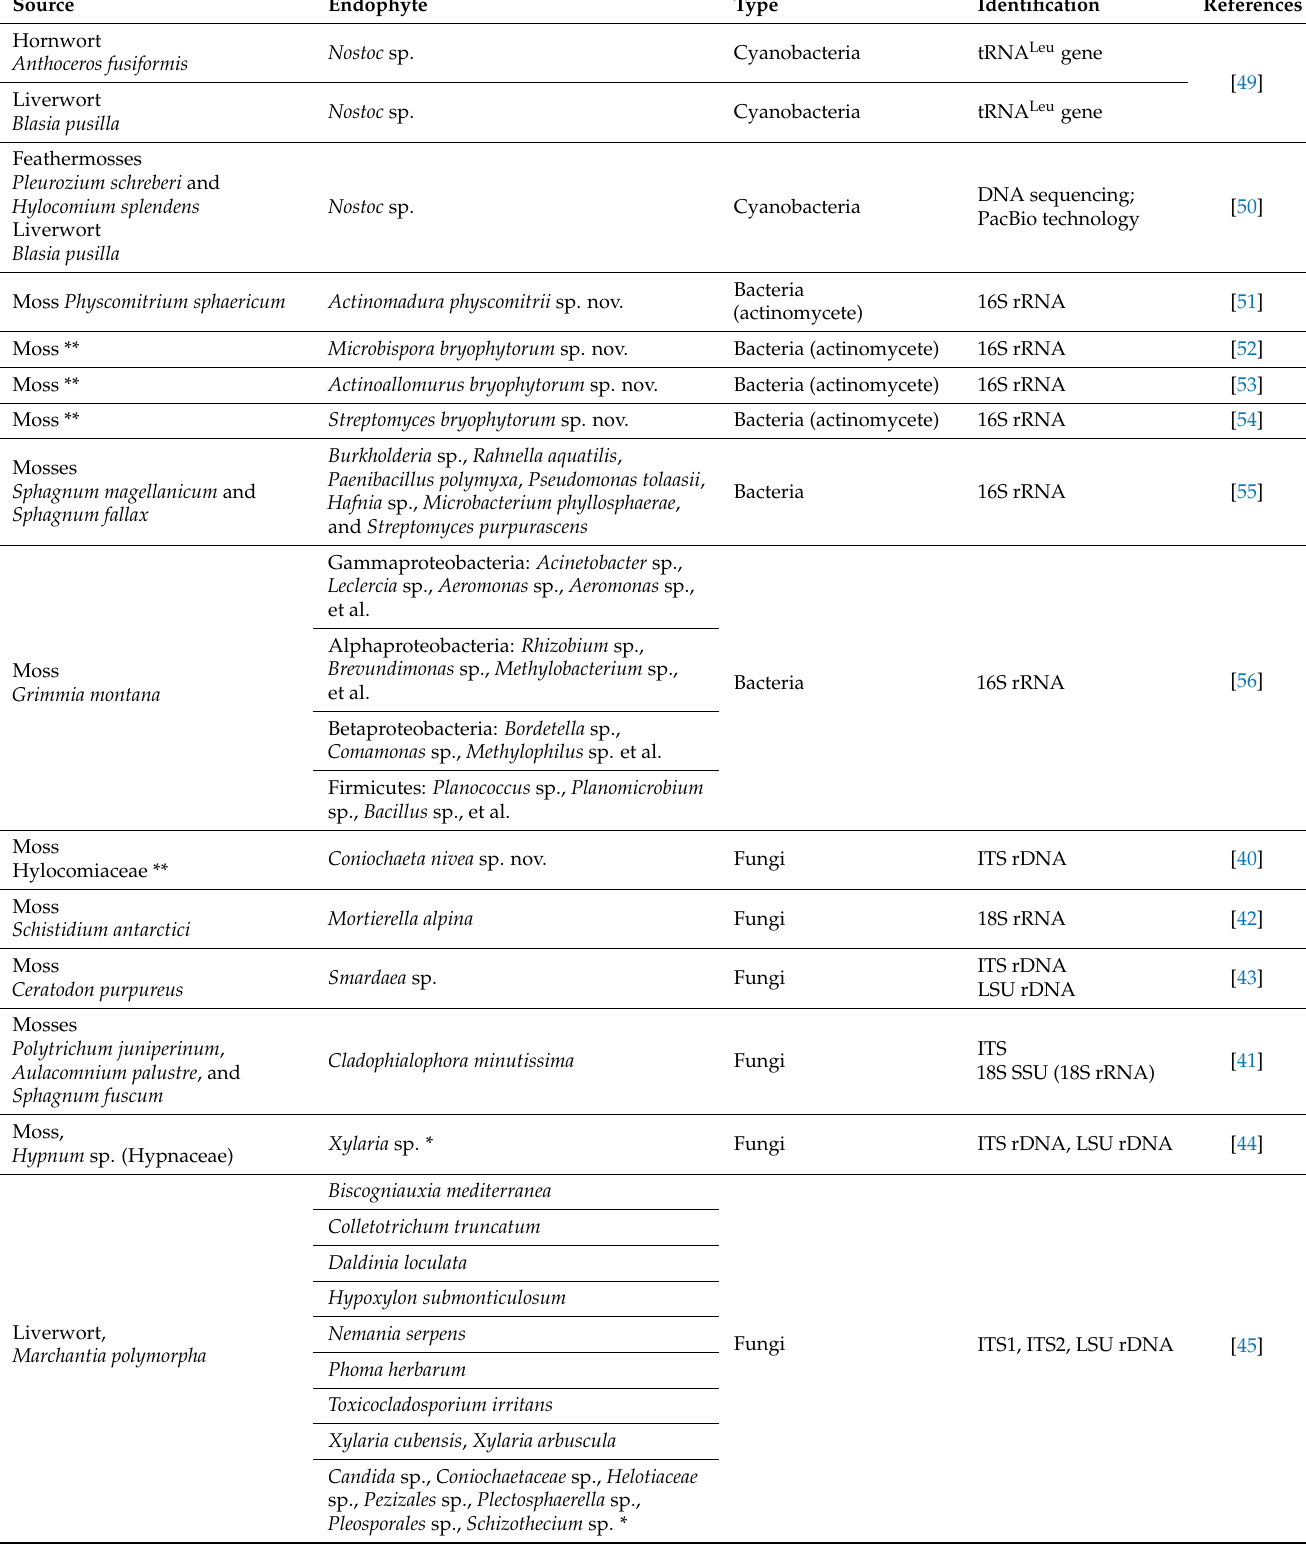
Table 1. Biodiversity of endophytes isolated from selected